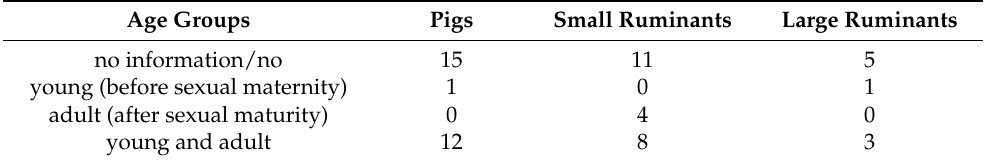
Table 1. Age groups of animals kept experimentally. Distribution of housed aged groups for the different farm animals; “no information” means that a question was not answered.